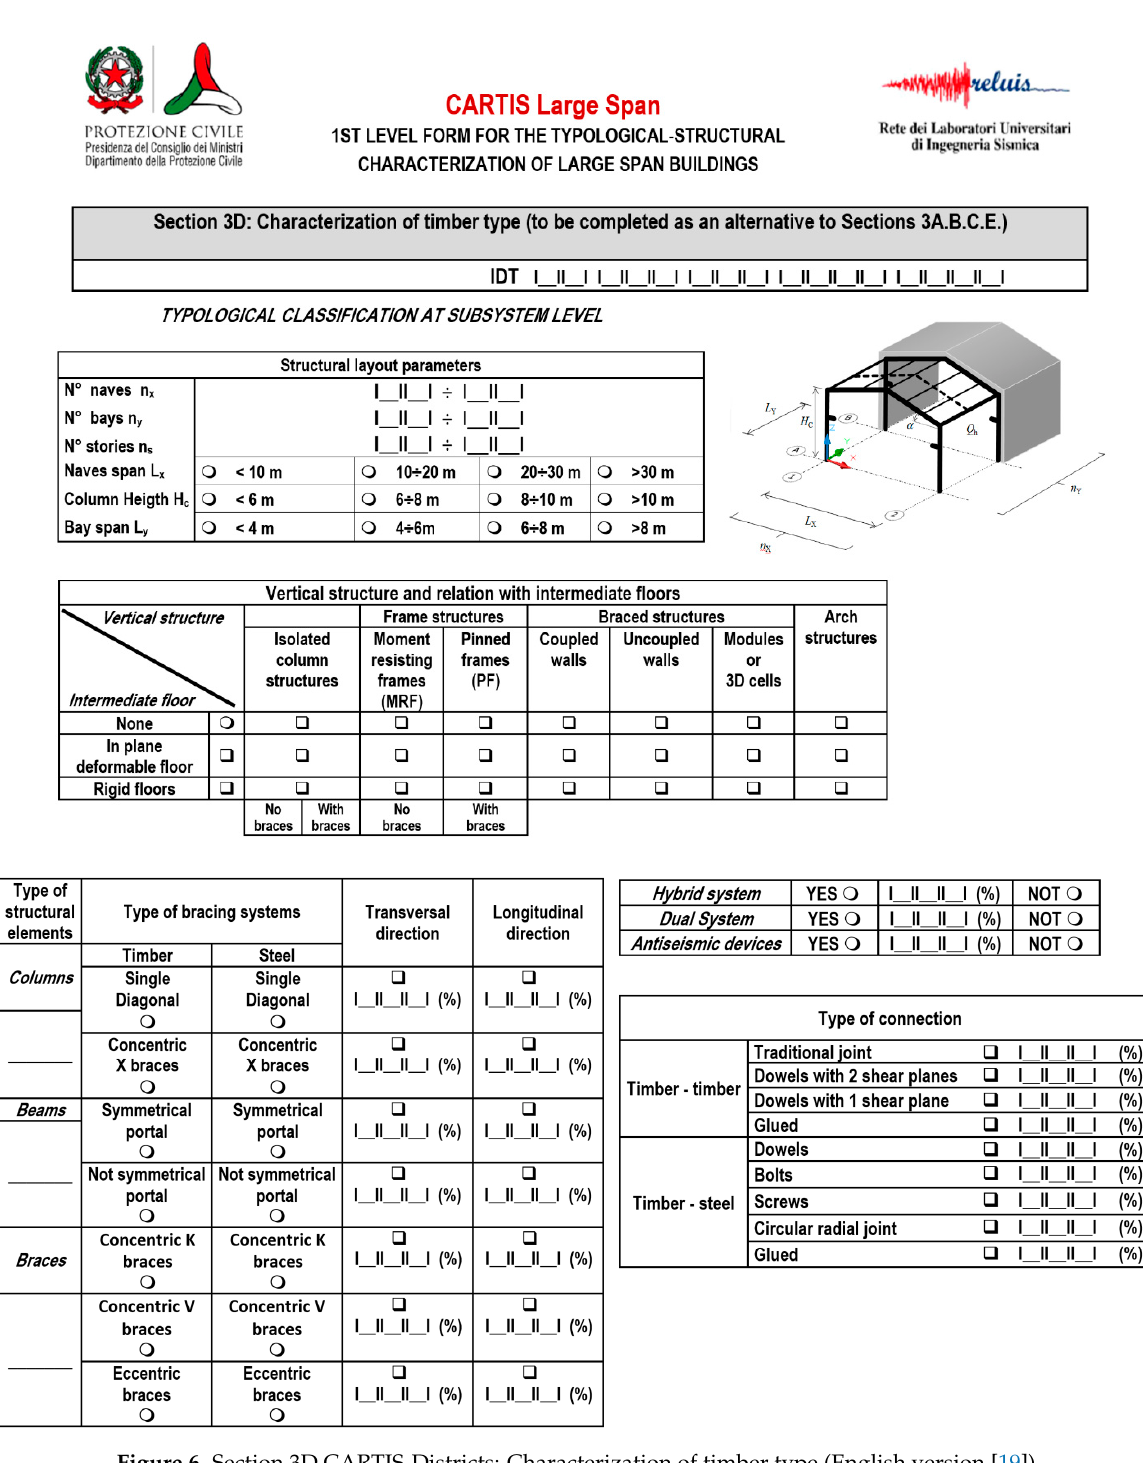
Figure 6. Section 3D CARTIS-Districts: Characterization of timber type (English version [19]).